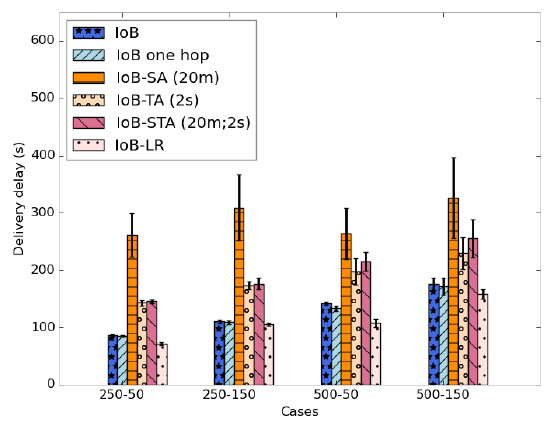
Figure 41. Average delivery delay comparison.